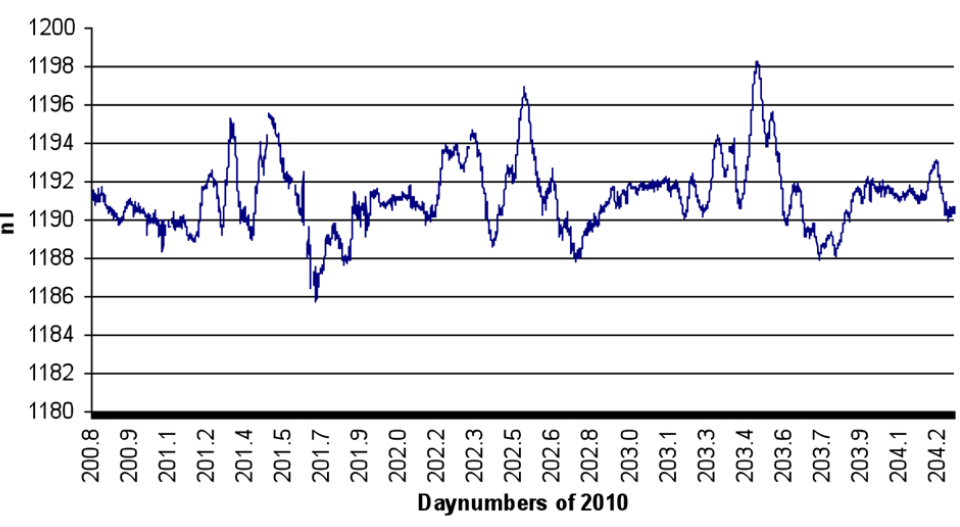
Figure 11 (above). The difference of X component magnetic field recorded between KRBP repeat station and Tihany observatory (minute mean values). Figure 12 (bottom page). The Y base values of the DIDD vs. the total field difference measured between the repeat station and the DIDD site at KRBP station between 20.07.2010. and